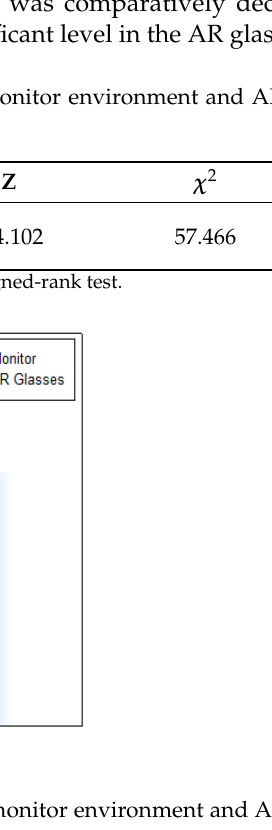
Table 6. Comparison of the blink rate in the VR HMD environment and AR glasses environment ( n = 21).